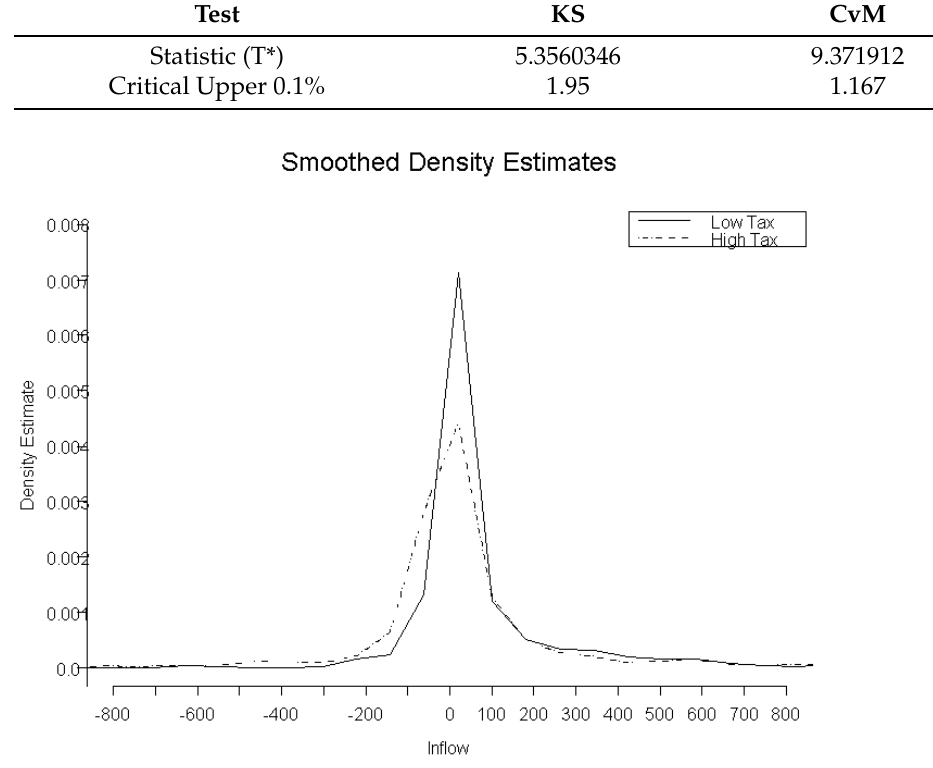
Figure 4. Inflow of mutual funds. Figure 4: In(cid:135)ow of Mutual Funds